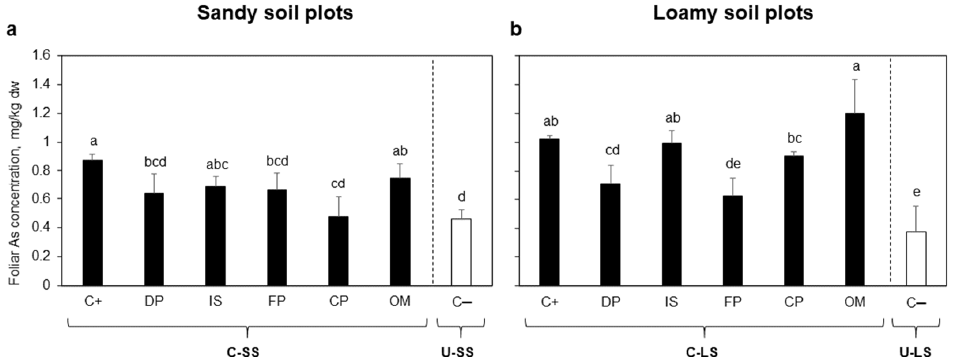
Figure 2. Arsenic concentration in the edible tissues of lettuces (in dry weight basis) grown in ( a ) sandy soils and ( b ) loamy soils. Bars are means ± SD ( n = 5). Different letters above the means indicate significant differences between treatments based on Tukey multiple comparison test ( p ≤ 0.05). Black bars represent contaminated soil under different treatments: C+ = Contaminated soil without amendment; DP = diammonium phosphate; FP = ferrous phosphate; IS = iron sulphate; OM = organic matter addition; CP= calcium peroxide. White bar represents uncontaminated soil: C- = uncontaminated soil without amendment. C-SS = contaminated sandy soil plot; U-SS = uncontaminated sandy soil plot; C-LS = contaminated loamy soil plot; and U-LS = uncontaminated loamy soil plot.